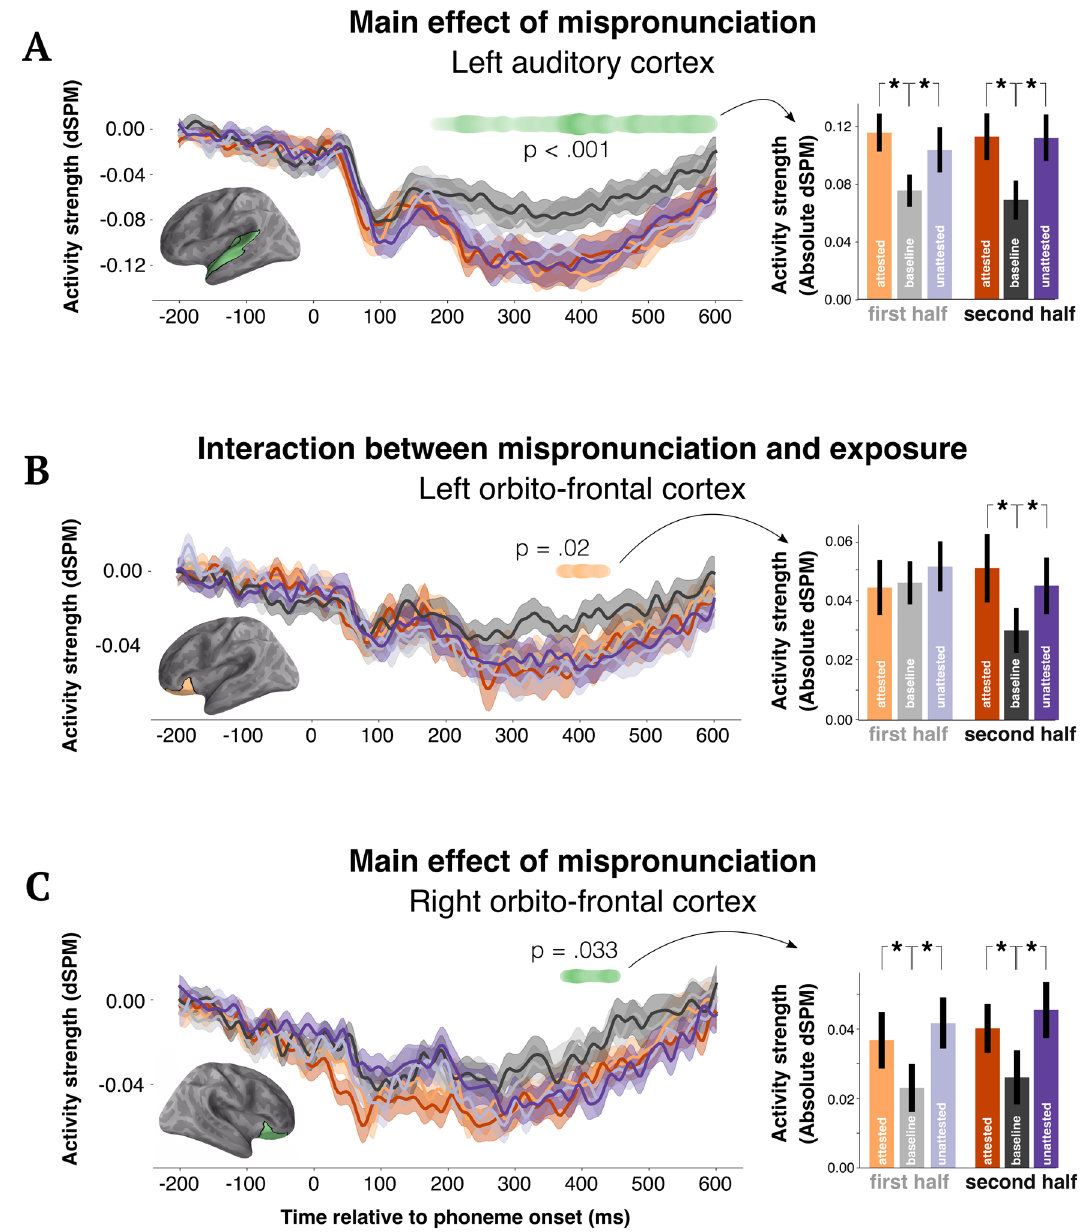
Figure 3. Average condition averages in regions of interest, with regression coefficients over time for a multiple regression model with factors: numerical count of exposures to the speaker; number of elapsed trials; picture match or mismatch, speaker identity and condition (baseline, attested, unattested). In each panel, the brain model shows the location of the area where the analysis was conducted. Barplots show absolute activity averaged over the temporal window of significance and over sources in the tested ROI. Note that the activity in the time- courses is “signed”, so has both positive and negative fluctuations, whereas in the right barplots we just show the absolute values of the activity so that the effects are directly visually comparable to the behavioral figures. Panel ( A ) shows a main effect of mispronunciation: regardless of exposure, non-canonical speech always elicits more activity in auditory cortices. Panel ( B ) shows an interaction effect whereby prefrontal signals decrease for baseline phonemes over exposure whereas non-canonical speech requires its engagement. Panel ( C ) shows a main effect of mispronunciation in the right orbital-frontal cortex, similar to the pattern we observe in auditory